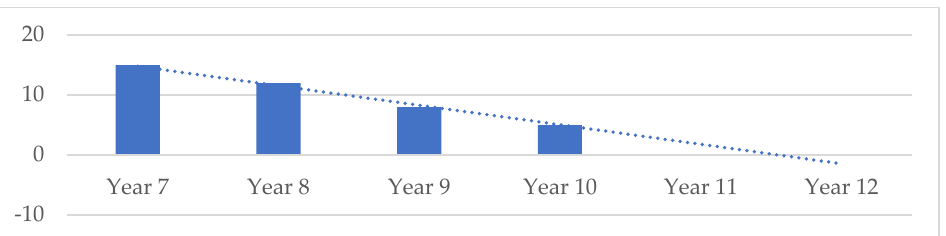
Figure 3. Participants by year of study.